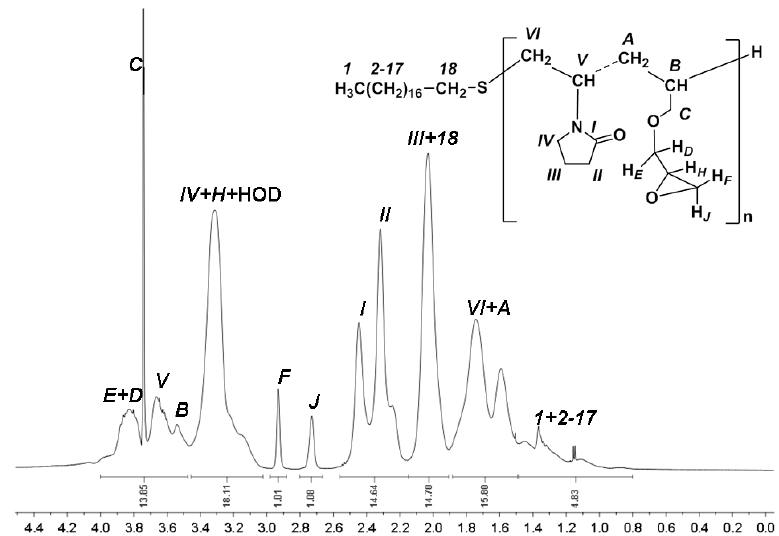
Figure 1. 1 H NMR spectrum of the